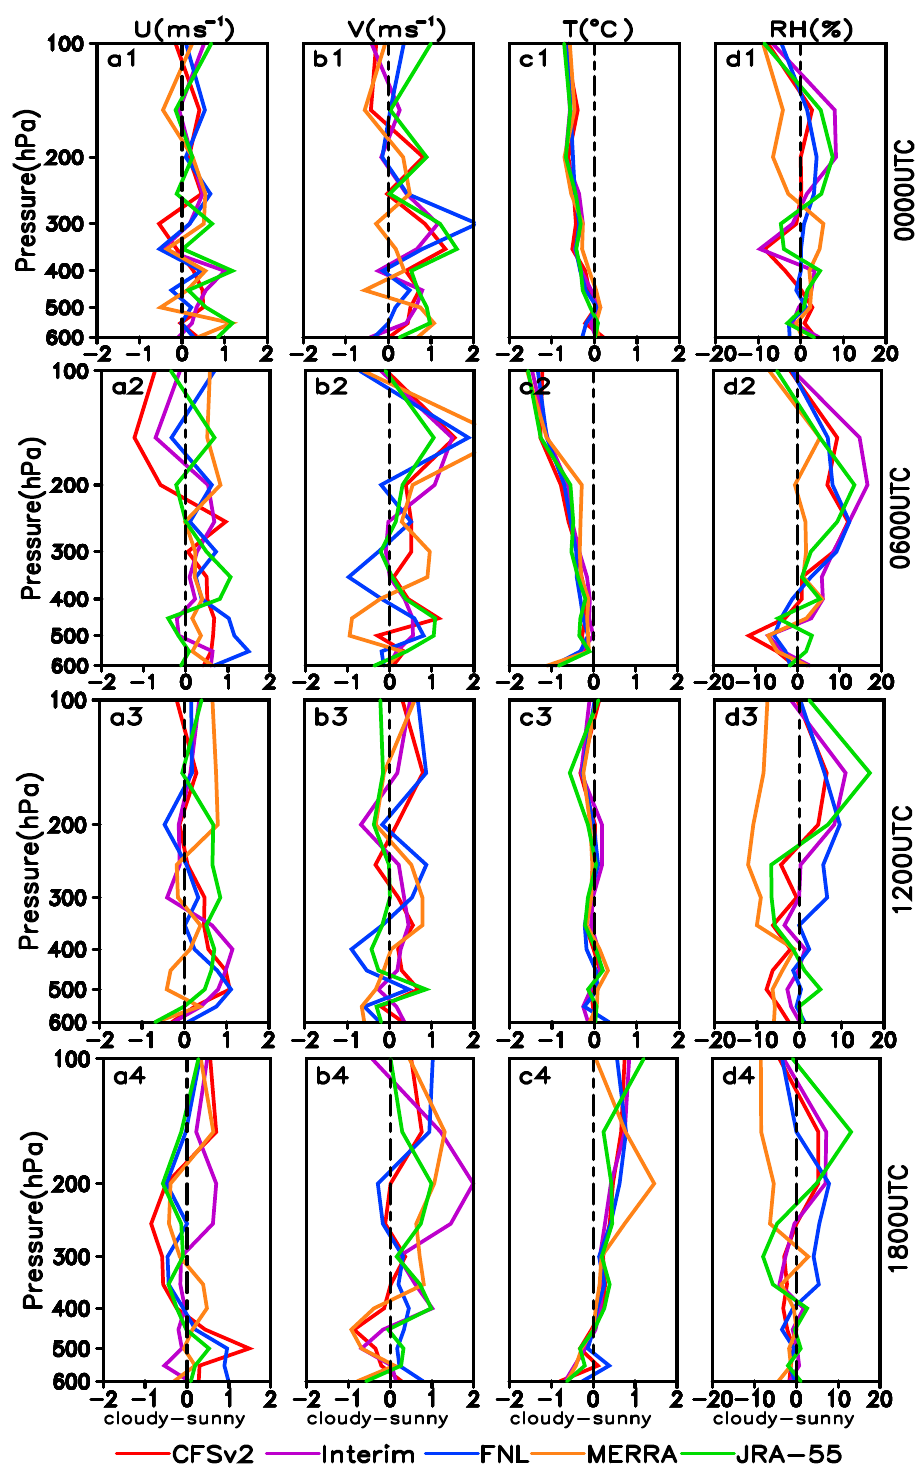
Figure 6. The difference of absolute values of the mean bias of U ( a1 – a4 ), V ( b1 – b4 ), T ( c1 – c4 ), and RH ( d1 – d4 ) between those occurring on cloudy days and on sunny days in the GDs against the radiosonde data, averaged over sounding five sites in the basin.